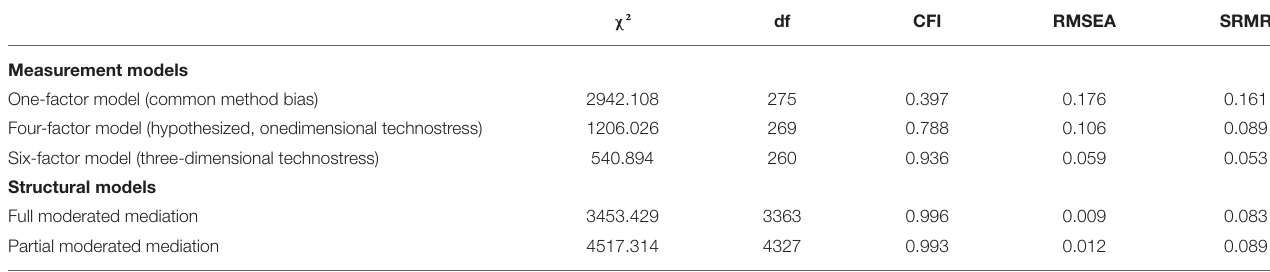
χ ² df CFI RMSEA SRMR